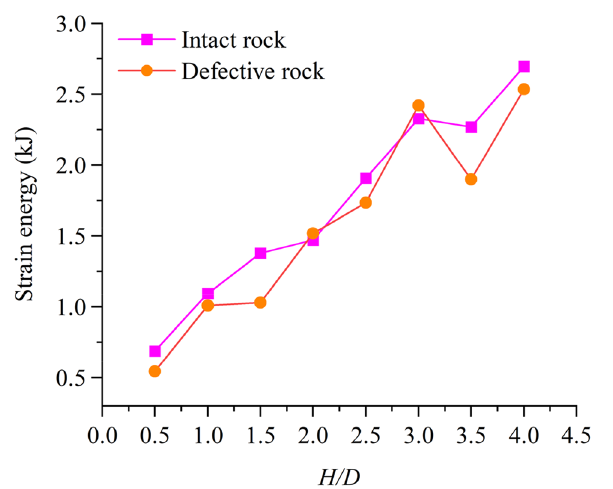
Figure 8. Relationship between strain energy.